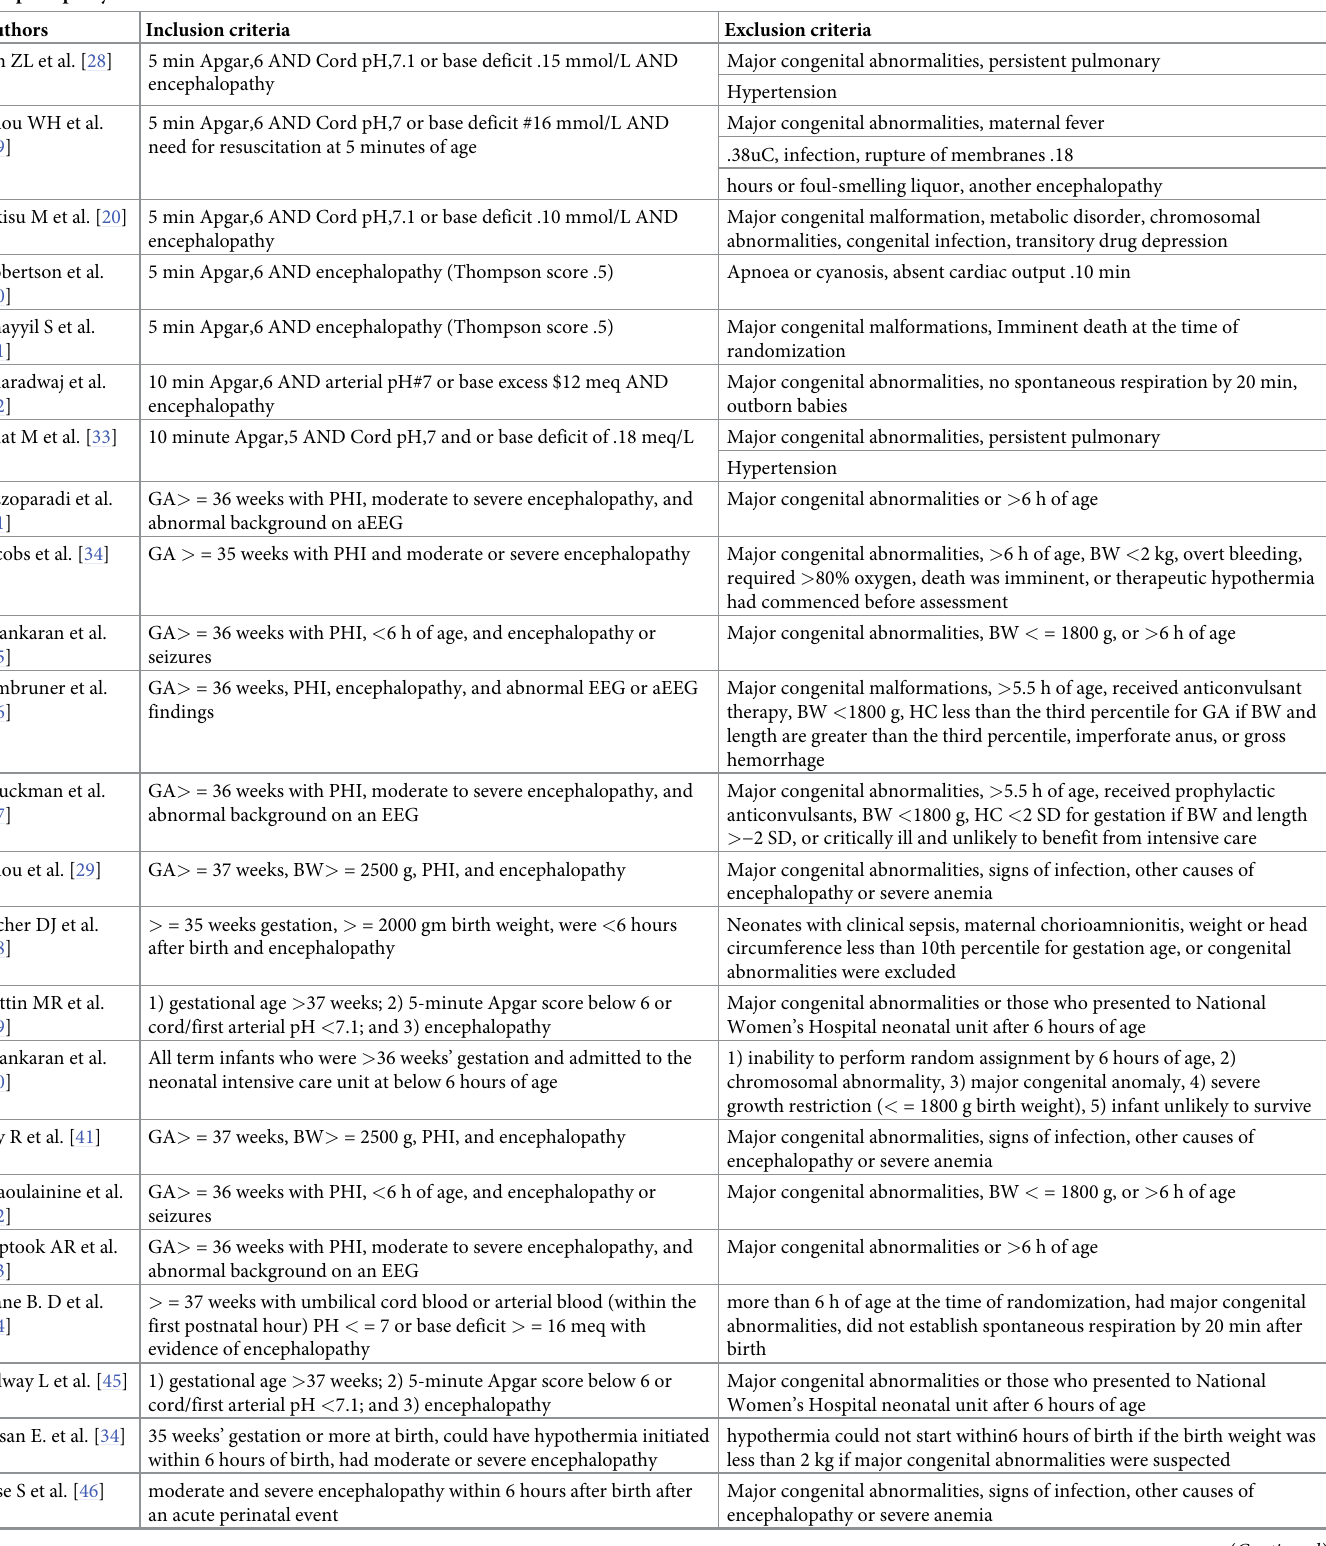
Table 4. Inclusion and exclusion criteria of included studies on the effects of therapeutic hypothermia on death among asphyxiated neonates with hypoxic-ischemic